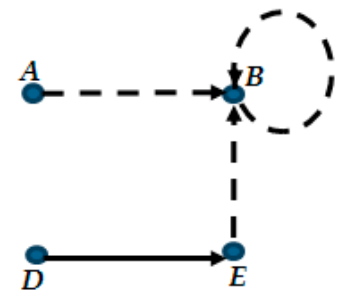
Figure 3. A four-person good puzzle with minimum number of edges.